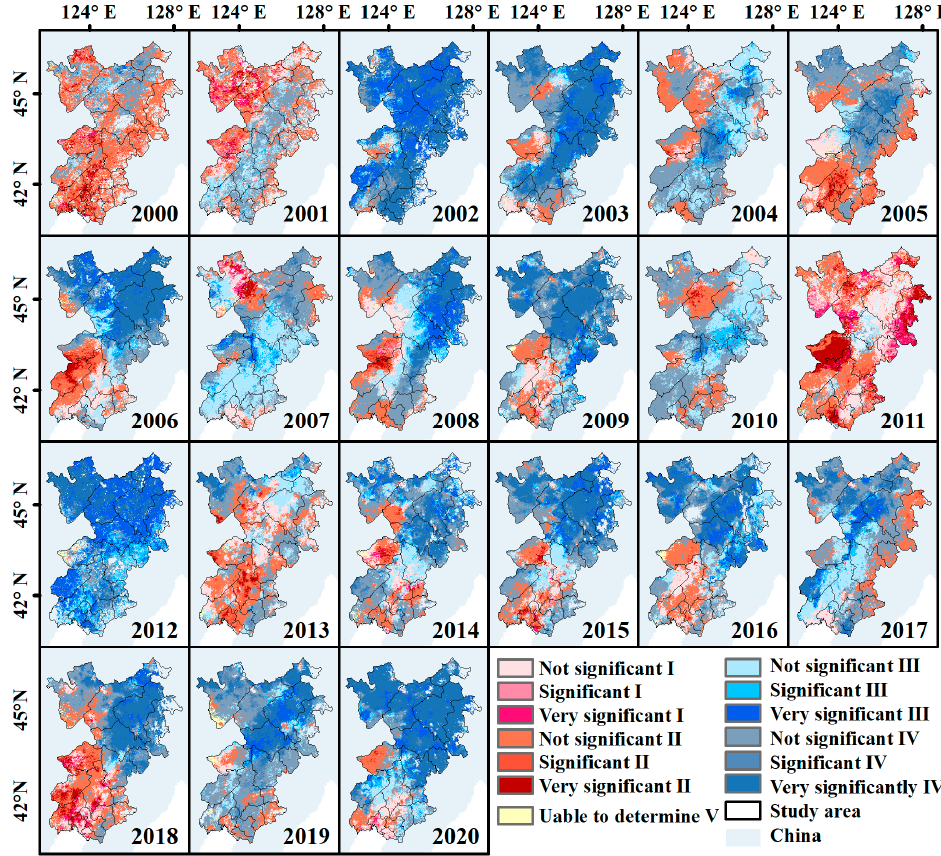
Figure 7. Spatiotemporal distributions of the coupling types of drought and waterlogging in the maize croplands in Songliao Plain for 2000–2020 and their significance levels (I: drought to waterlogging; II: continuous drought; III: waterlogging to drought; IV: continuous waterlogging; and V: no predictable trend).